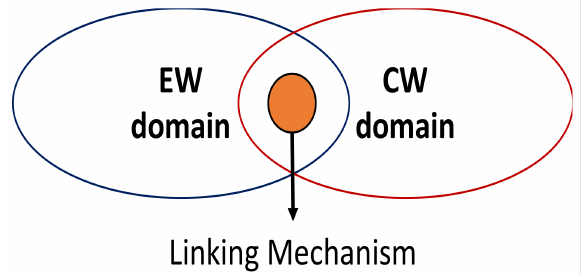
Figure 2. Linking mechanism between EW and CW